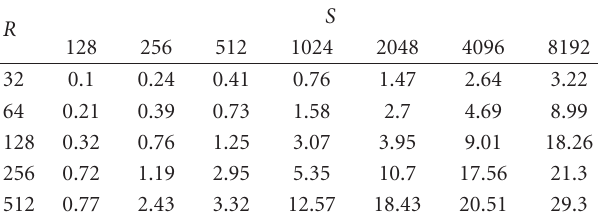
Table 2: CPU/GPU performance